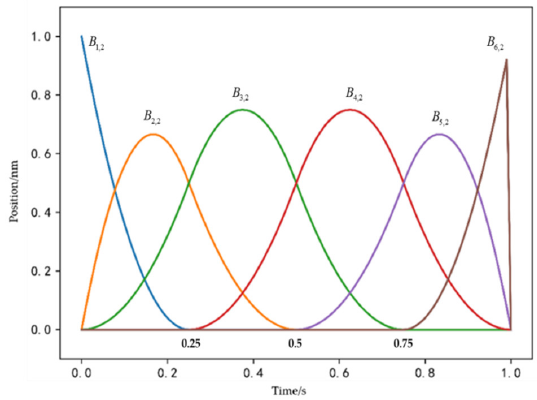
Figure 4. Quadratic univariate B-spline basis functions (polynomial degree p = 2). In order to meet the above boundary conditions of optimal control for a collision avoidance point, the B-spline curve is utilized to parameterize the position information, speed information, and heading information of the own ship (OS) and the TS. The position information is parameterized to Equation (9). where x OS and y OS are the longitude and latitude of the position of the OS, respectively.